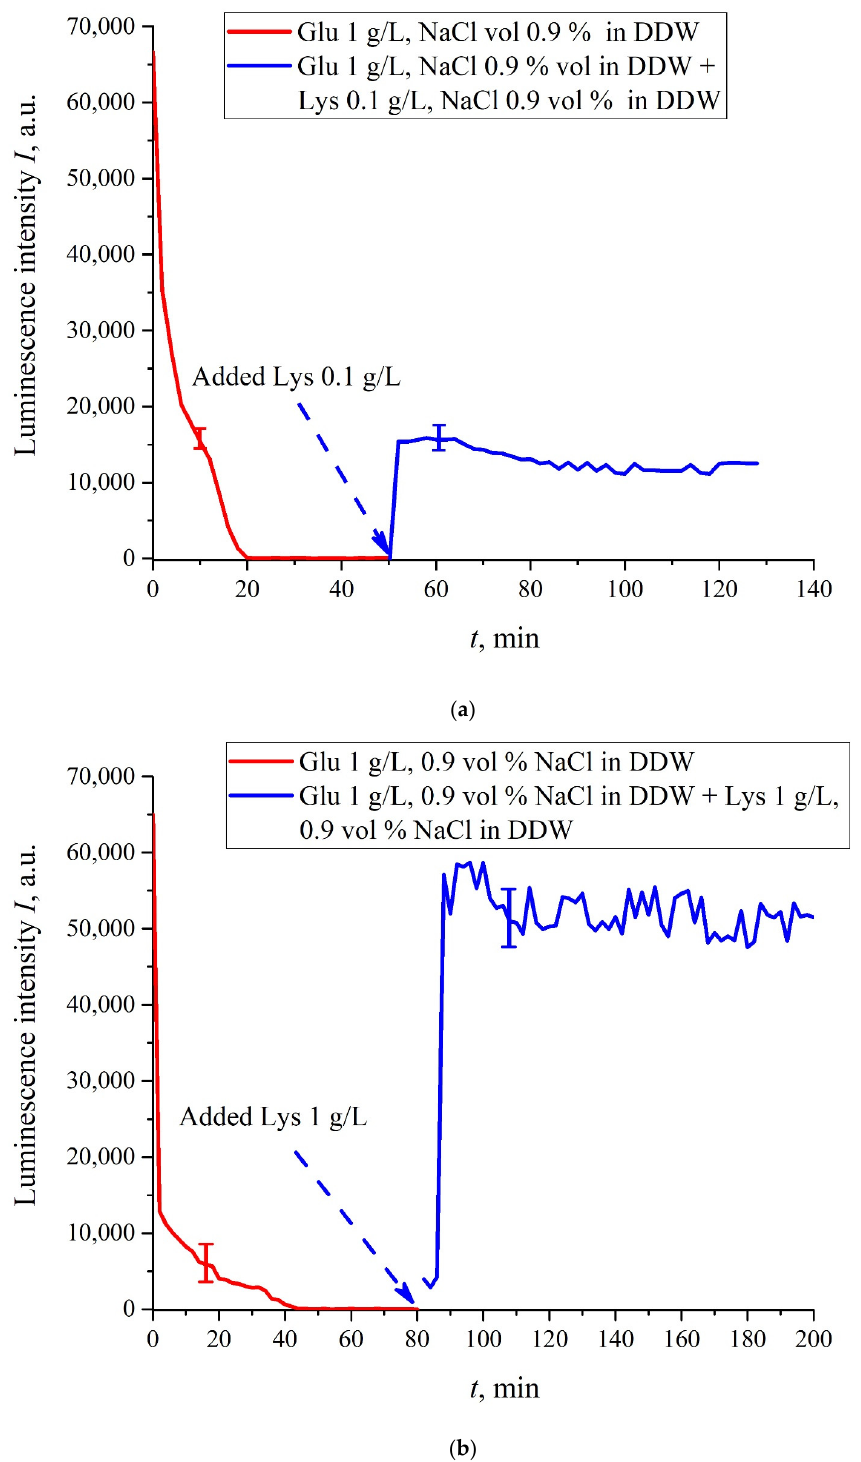
Figure 8. Luminescence intensity I ( t ) vs. the soaking time in DDW- based saline (0.9 vol.% NaCl) containing suspension of glutamic acid (1 g/L). A lysine suspension (1 g/L, DDW- based saline also) was added at 50/80-th minute; the volumes V of suspensions of glutamic acid and lysine are equal. Panel ( a ) corresponds to adding the lysine suspension with concentration 0.1 g/L at 50-th minute. Panel ( b ) corresponds to adding the lysine suspension with a concentration of 1 g/L at 80-th minute.